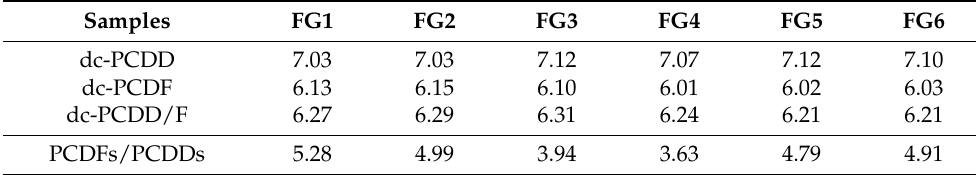
Figure 3. ( a ) I-TEQ concentration of PCDDs and PCDFs; ( b ) inhibition efficiency of PCDDs and PCDFs. Table 5. Weight average level of chlorination and PCDF/PCDF